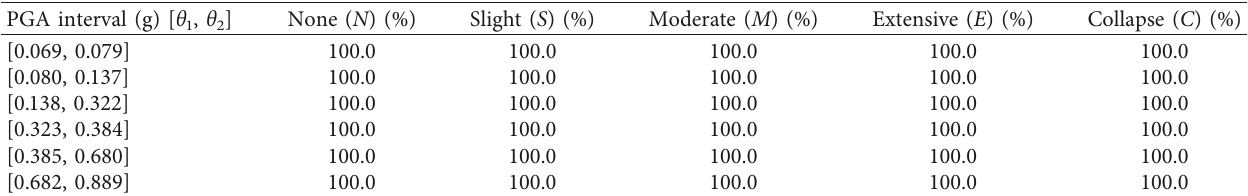
Table 6: Possibility measure of damage sets in equation (16) using equation (11) based on the possibility distribution in Figure 4. PGA interval (g) [ θ 1 , θ 2 ]